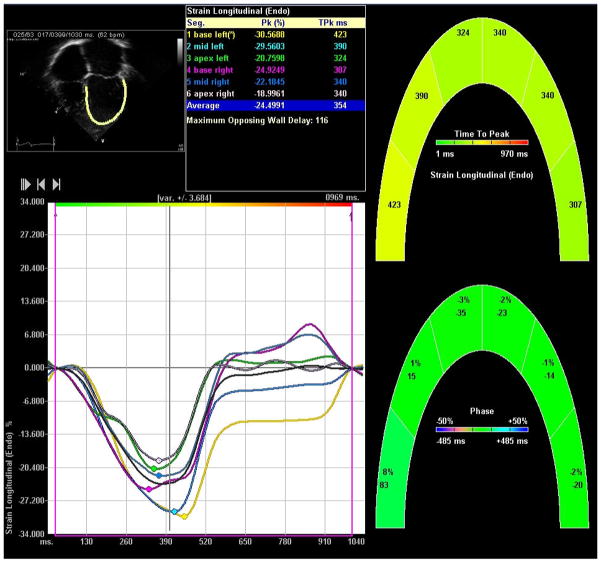
VVI longitudinal strain output.